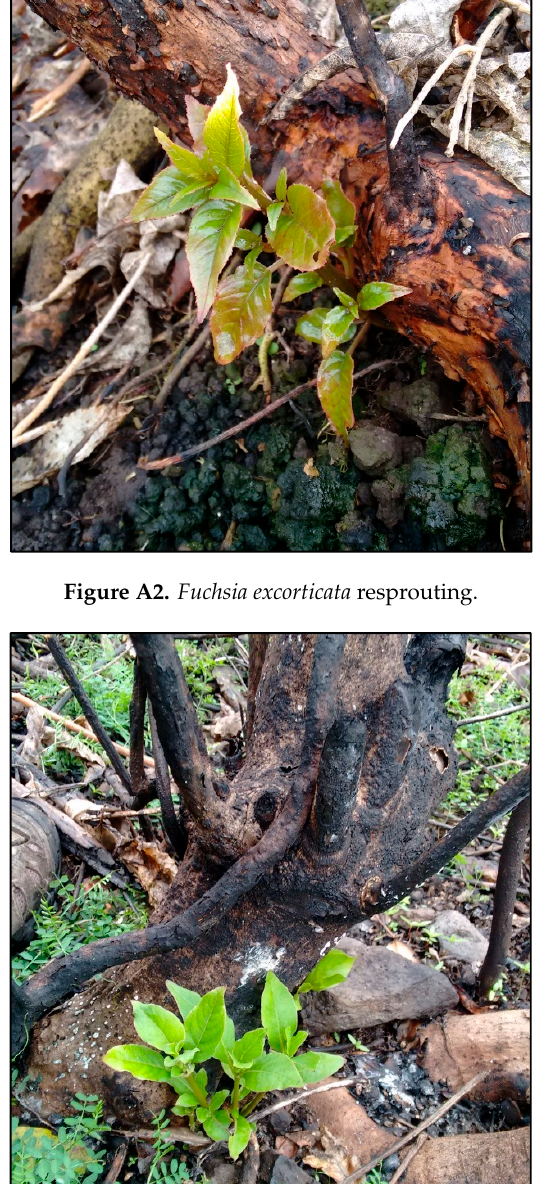
Figure B2. Fuchsia excorticata resprouting. Figure B3. Coprosma robusta/lucida Figure A3. Coprosma robusta / lucida resprouting. Figure B4. Griselinia littoralis resprouting. Figure B5. Melicytus ramiflorus resprouting